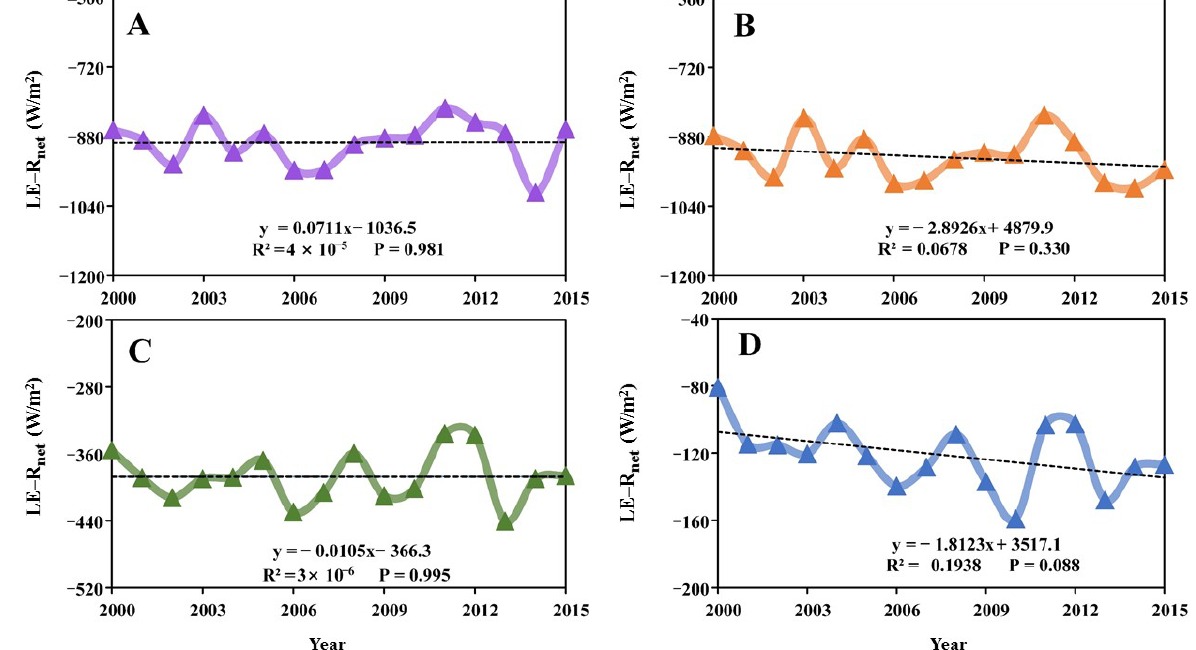
Figure 18. Trend of LE − R net from 2000 to 2015 (( A ) Jinan City, ( B ) Zhengzhou City, ( C ) Lanzhou City, ( D ) Xining